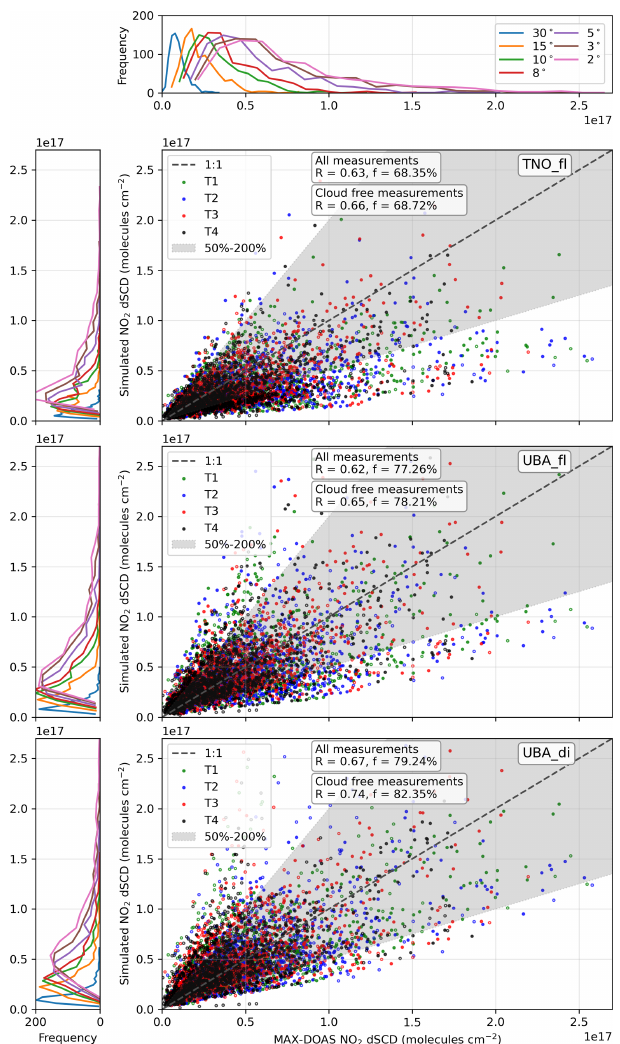
Figure 12. Scatter plot of simulated dSCDs against measured dSCDs for all the four telescopes combined for the elevation an- gles 2, 3, 5, 8, 10, 15 and 30 ◦ . The filled circles correspond to the cloud-free scenarios, while the empty circles correspond to the cloudy conditions. The Pearson correlation coefficient ( R ) and the fraction of simulated dSCDs within 50%–200% of the measurements ( f ) are annotated in the respective panels separately for all measurements and for cloud-free conditions only. The top, middle and bottom panels correspond to TNO fl , UBA fl and UBA di , respectively. The frequency distribution of the measured dSCDs is shown above the first panel, and those for the simulated dSCDs from the three set-ups are shown on the left of the respective scatter plots.